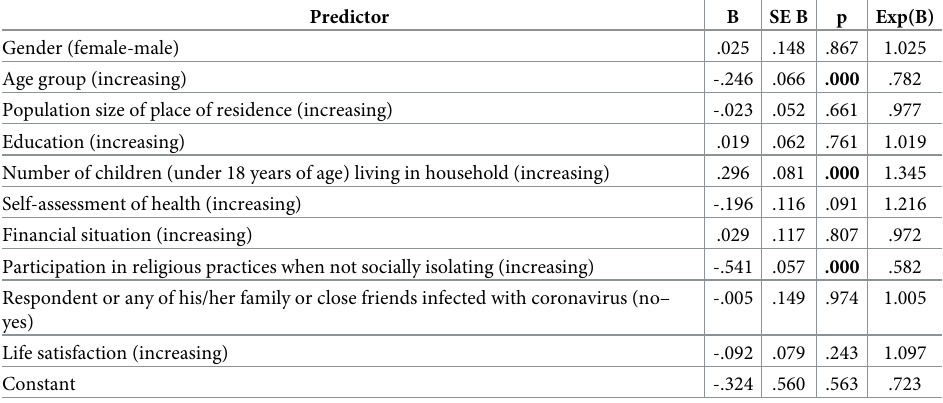
Table 5. The logistic regression analysis predicting decrease in religious commitment based on respondents’ socio-demographic characteristics (N = 1761 � ).